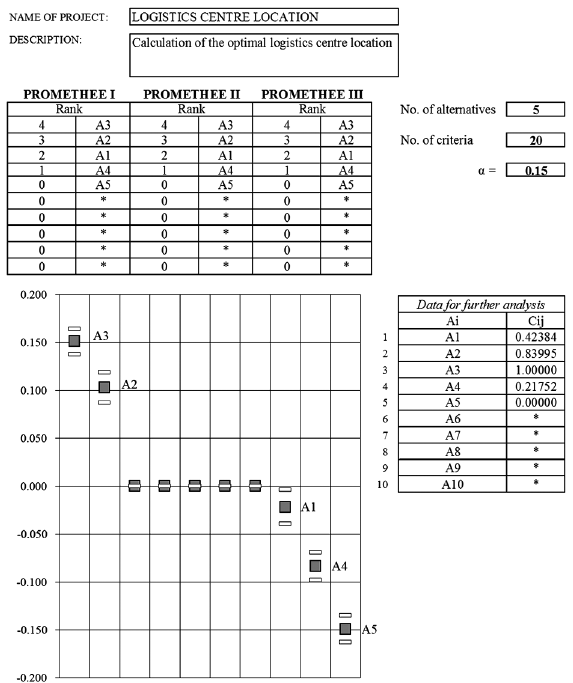
Fig. 6. Report with the results of multicriteria analysis